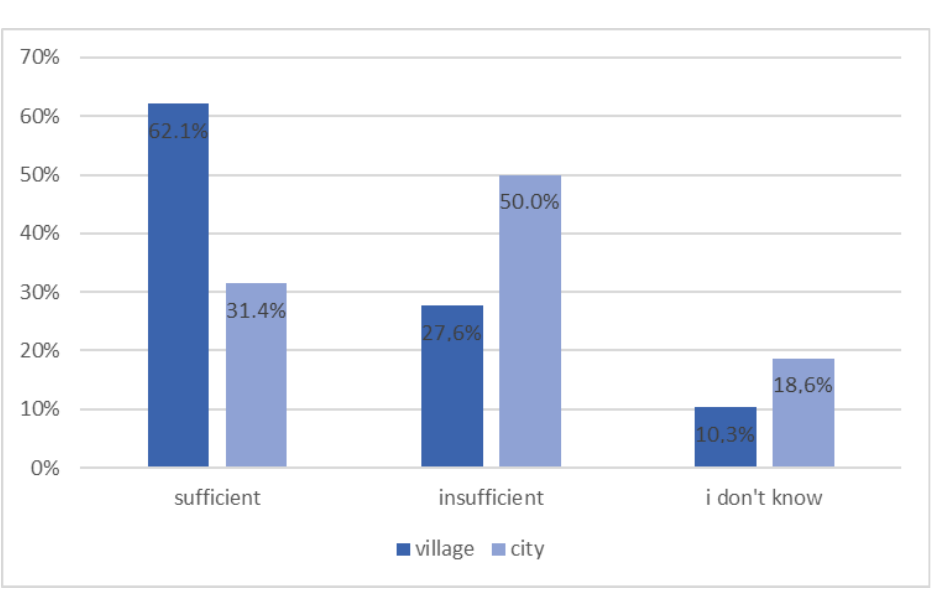
Figure 3. Patients’ self-assessment of their knowledge about diabetes depending on the place of residence ( n = 131, p = 0.011).